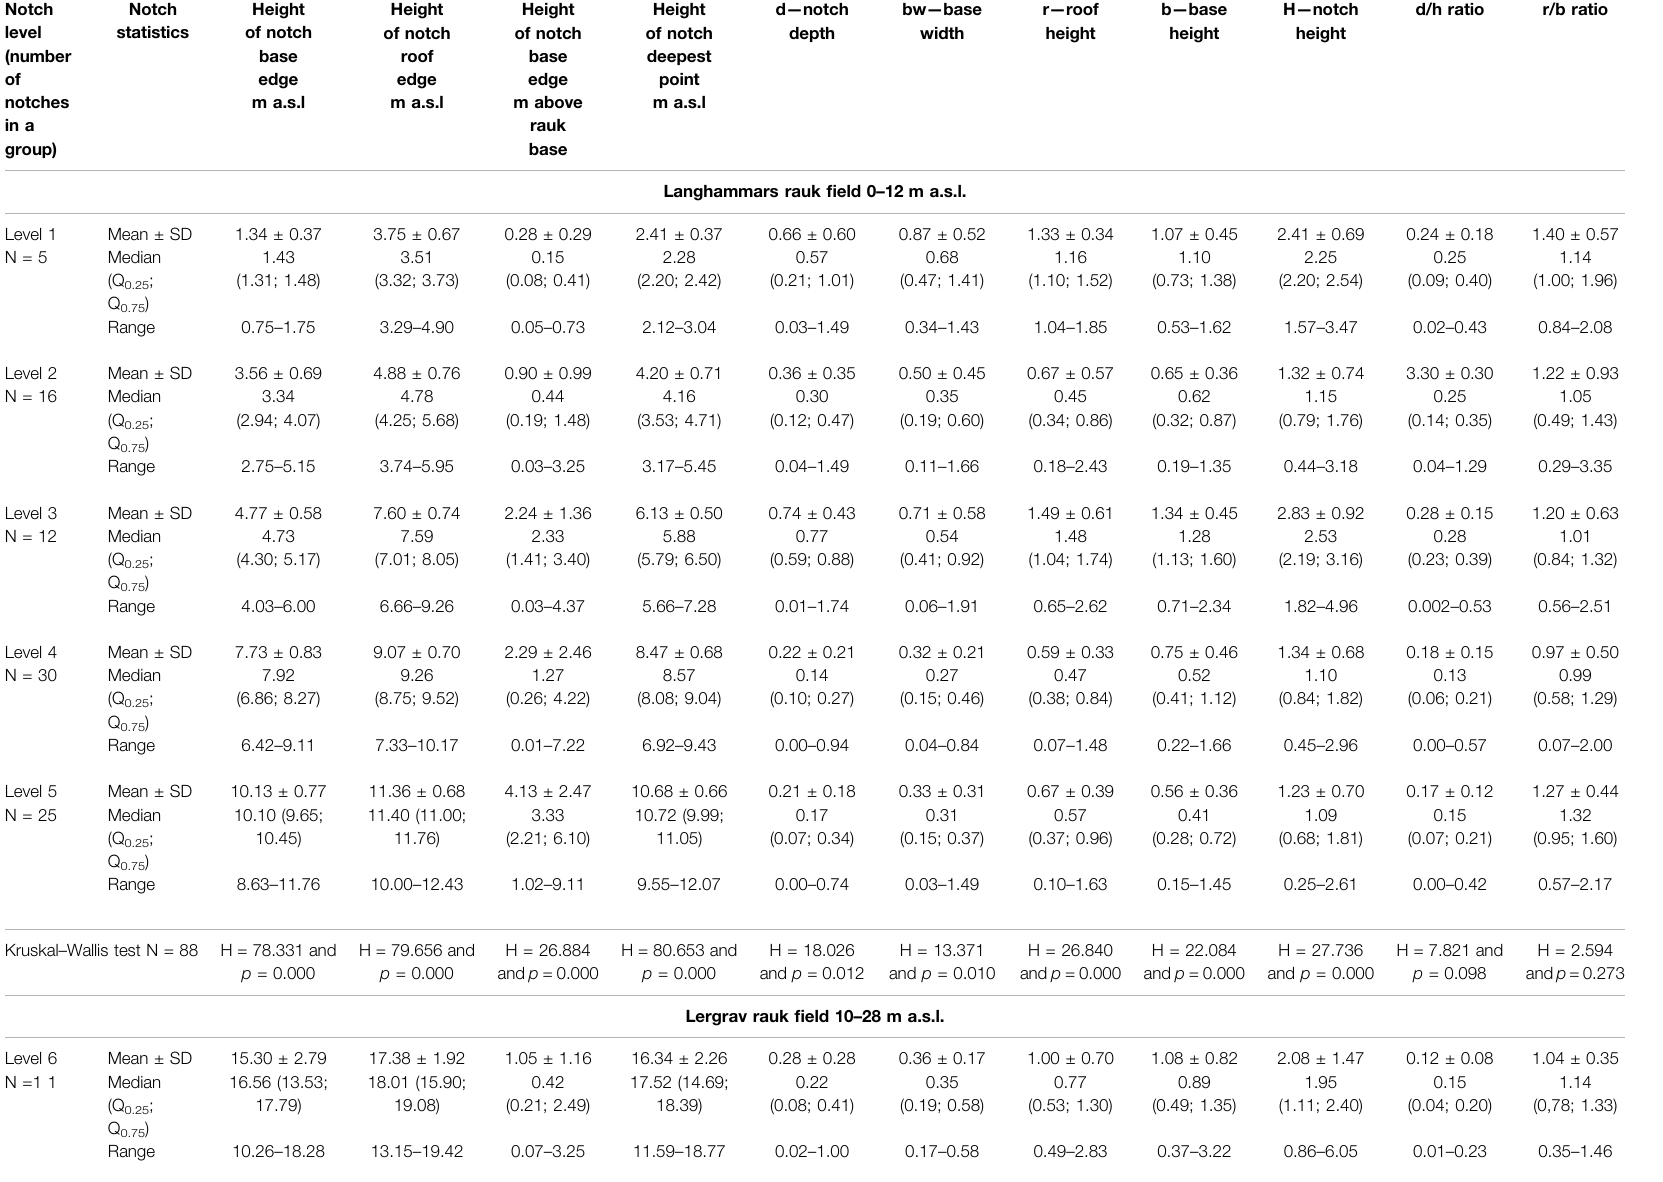
TABLE 1 | Morphometric characteristics of rauk notches from Levels 1 – 5 (Langhammars) and Levels 6 – 8 (Lergrav). For notch parameters used in calculations, see Figure 3 . Notch